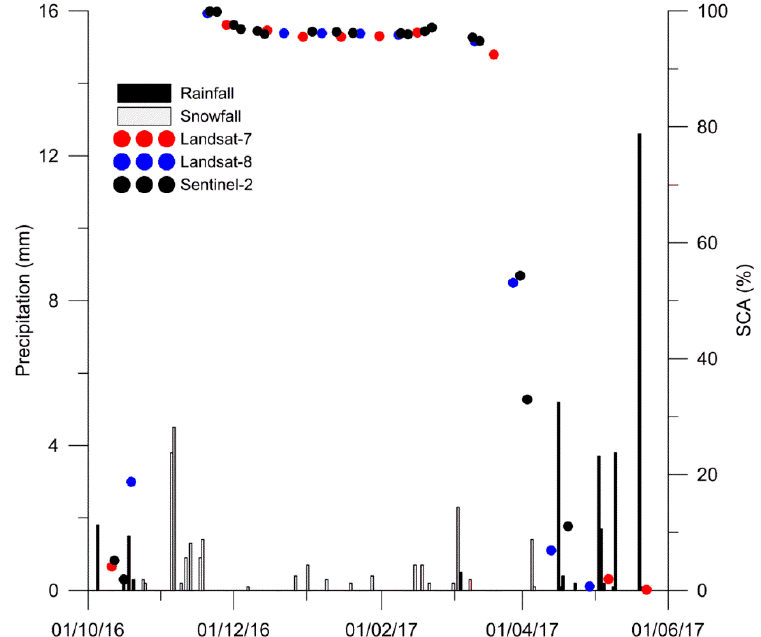
Figure 8. Precipitation events, distinguished as rain or snow, observed at the hydro-climatic station using the combination of albedo and air temperature measurements, and the inter-annual variability of SCA detected by different satellites over the Sugnugur catchment for winter 2016/2017. SCA detected by different satellites over the Sugnugur catchment for winter